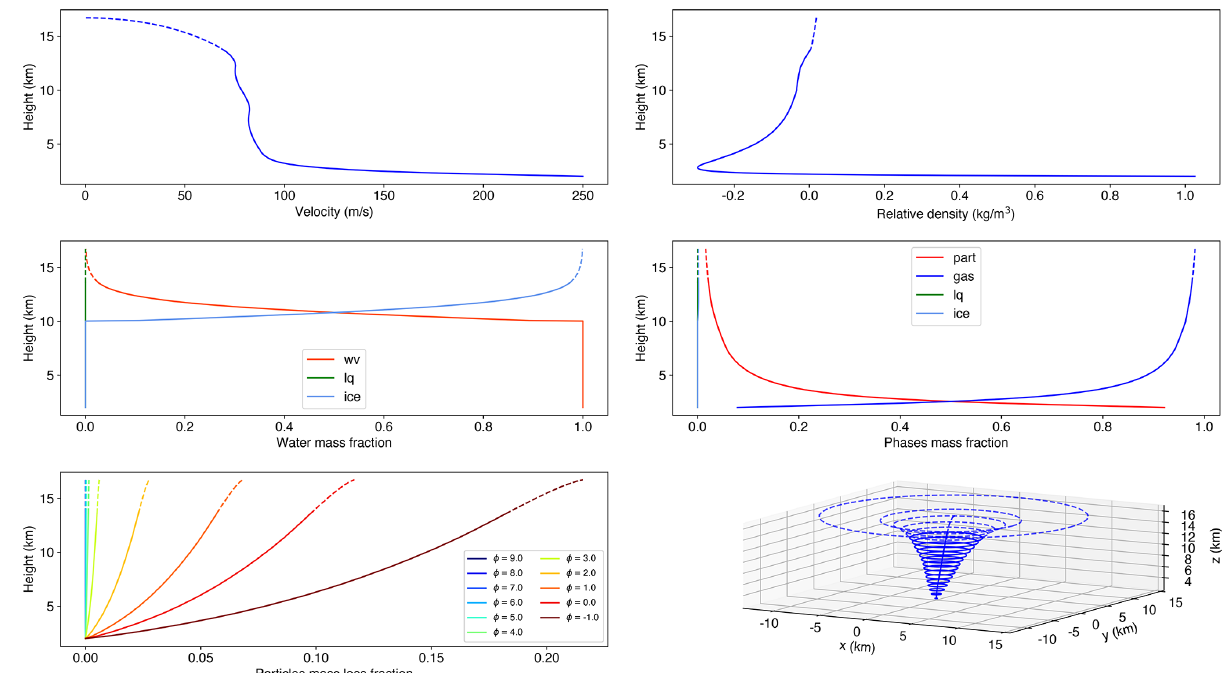
Figure 6. Same as Fig. 5 but for the second phase of the April 2015 Calbuco